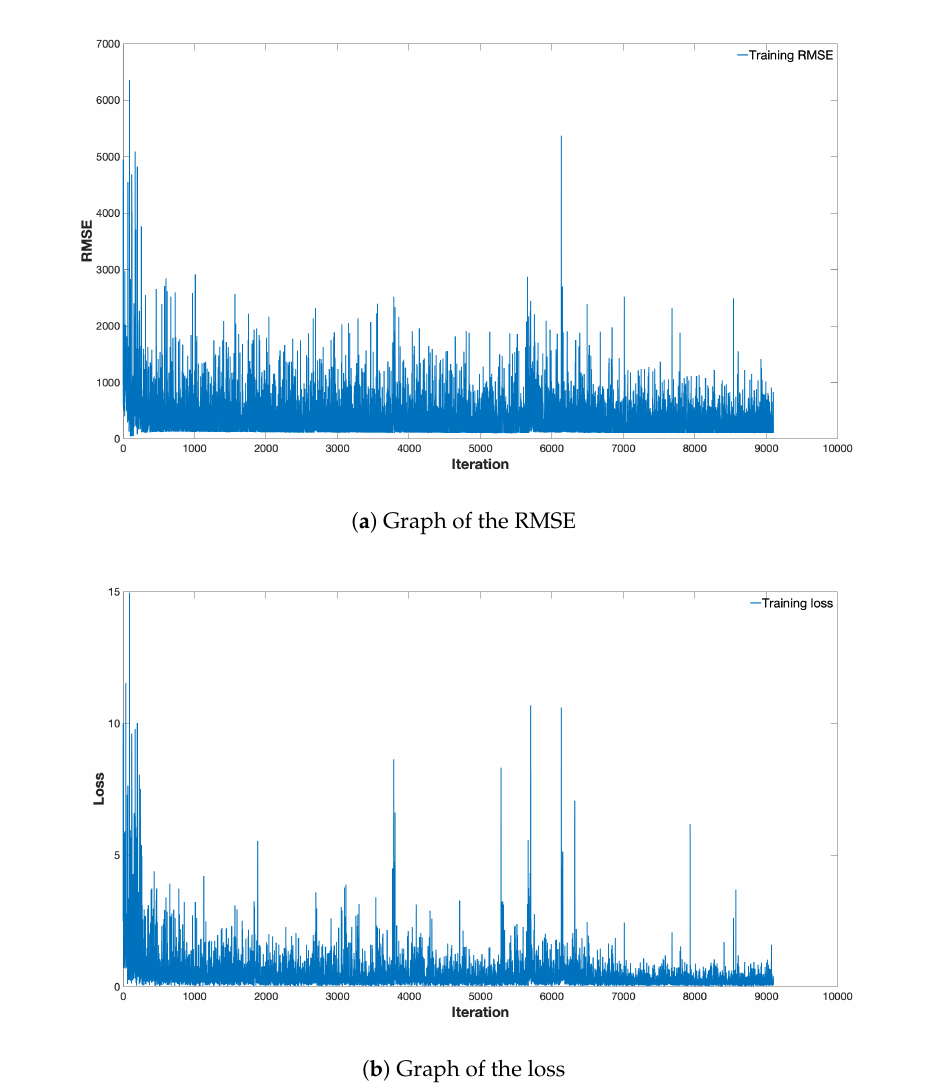
Figure 6. Graph of the loss and RMSE during the PRRS